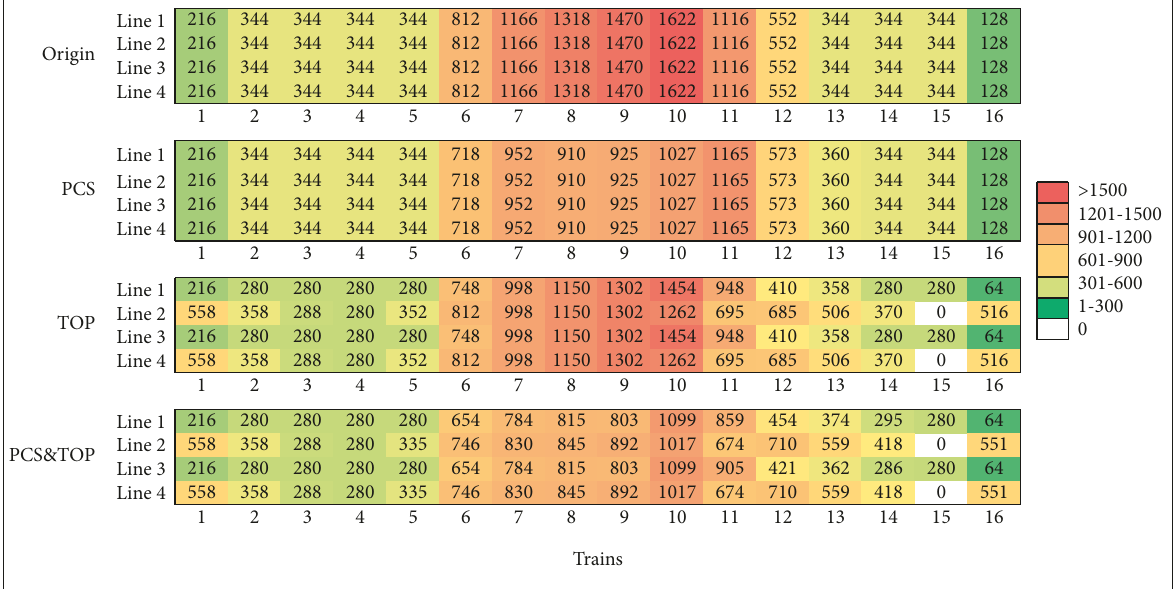
Figure 6: The platform waiting time of passengers in different solutions.